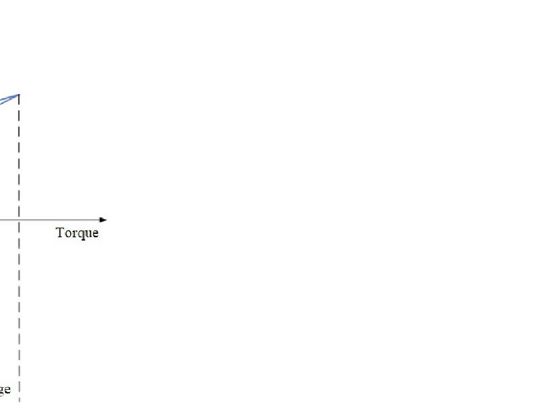
Figure 7. Loading mode of angle error